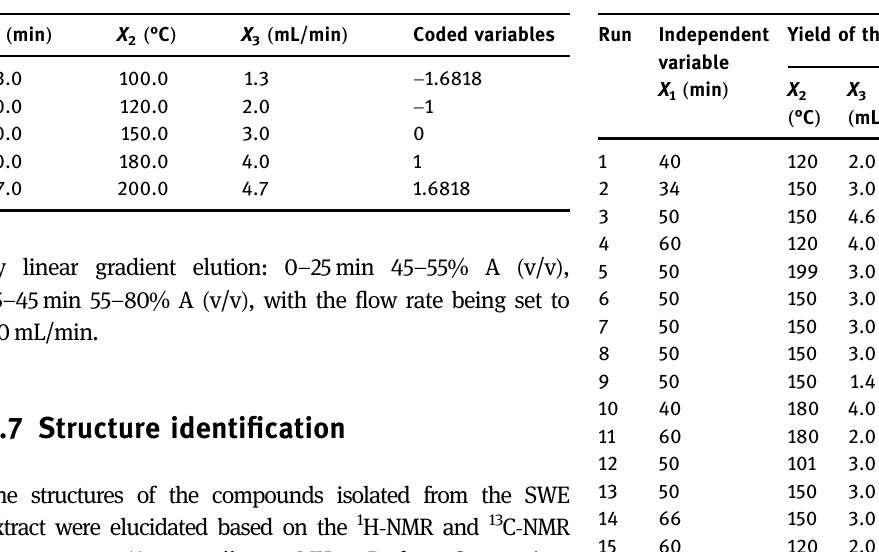
Table 2: CCD matrix and response values for the yield of the total